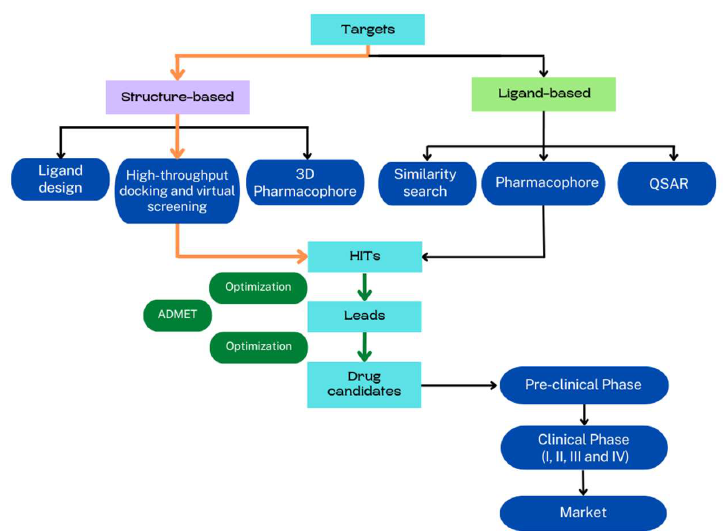
Figure 1. Schematic representation of the drug development cycle. Protocols are mainly classified into structure- and ligand-based methods. Identified hits are optimized to obtain potential candidates for experimental testing. ADMET (absorption, distribution, metabolism, excretion, and toxicity) criteria can be used as additional filters to reduce pre-clinical and clinical attrition rates of potential drugs. The orange arrows indicate the protocols